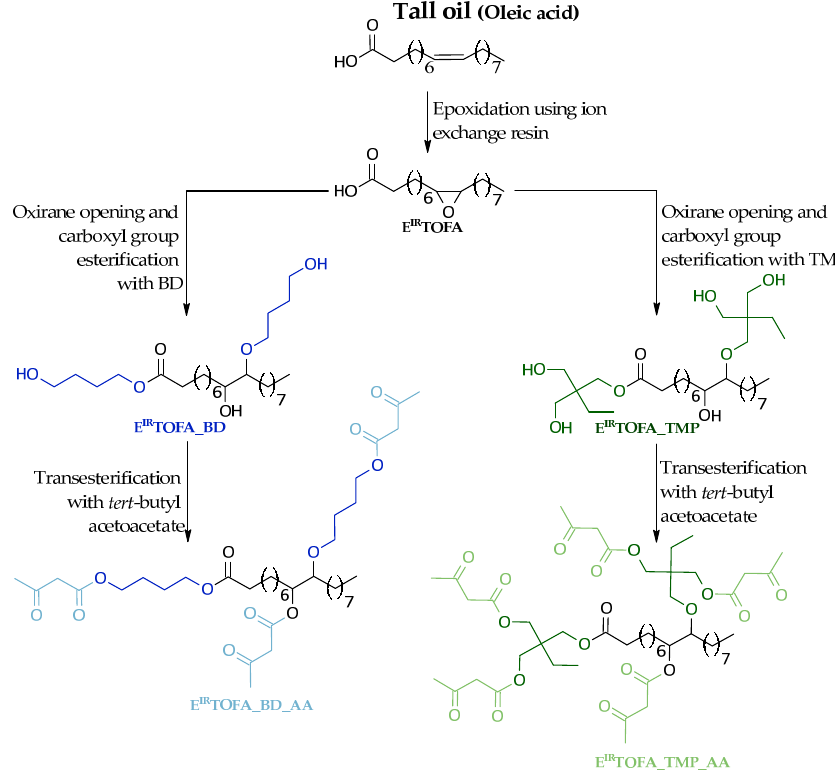
Figure 1. Idealized scheme of TOFA (oleic acid)-based Michael donor development.